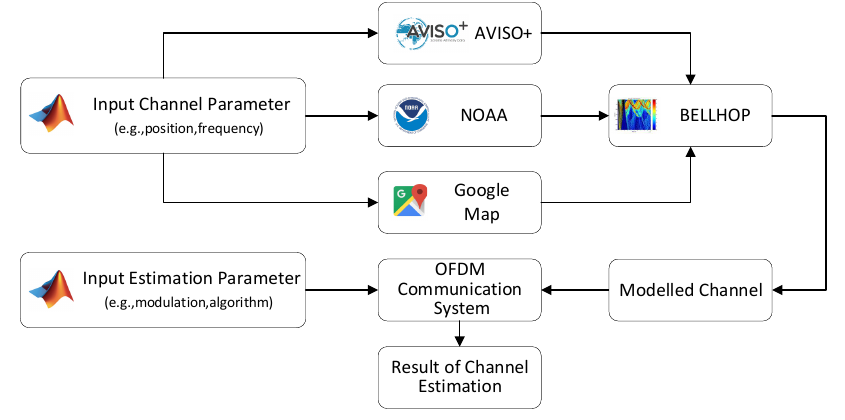
Figure 4. Data flow